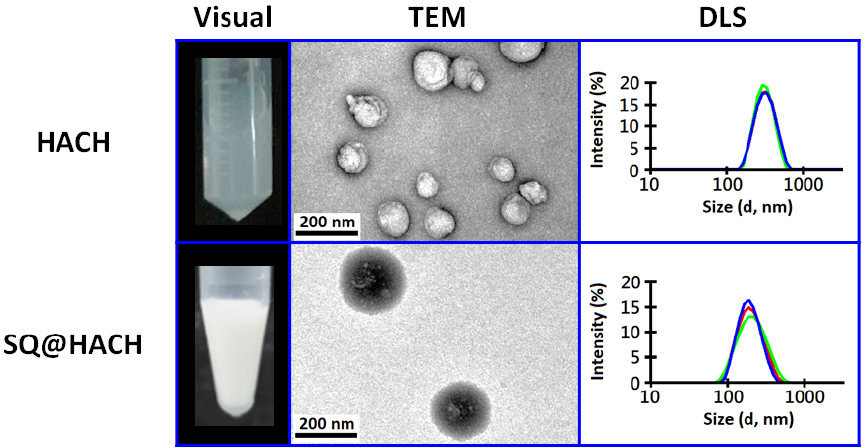
Figure 2. Visual appearance, TEM images and particle size distribution of HACH and SQ@HACH. The Size distribution was measured by DLS under 100-fold dilution of sample stock in water; colorful lines represent three different measurement results.